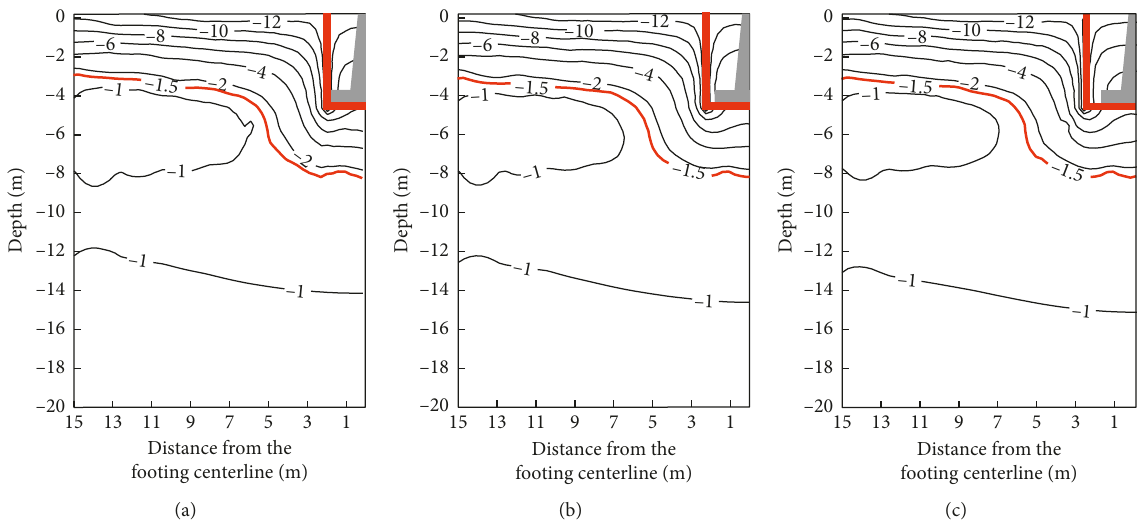
Figure 11: Temperature distributions of the duct-ventilated tower foundation on January 15. (a) D � 4 m. (b) D � 4.5 m. (c) D � 5m.